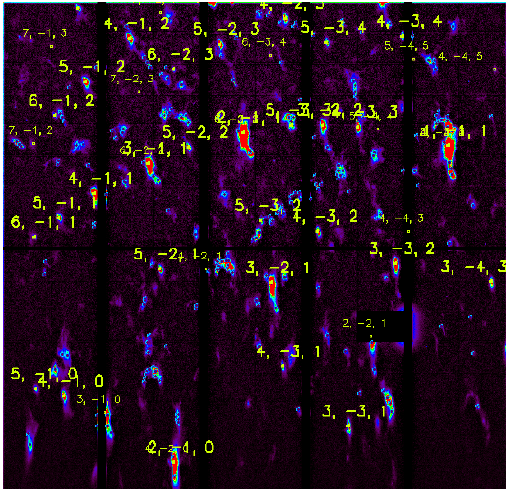
Figure 5. Indexed micro-Laue pattern of platiniferous tetra-auricupride from the western Sayans.